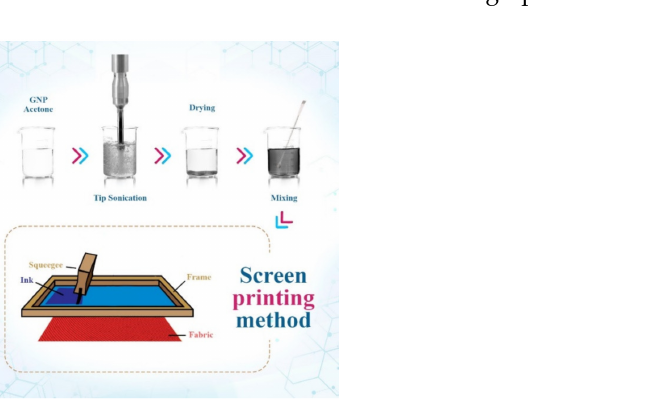
Figure 9. Screen printing process for the production of conductive cotton with graphene ink